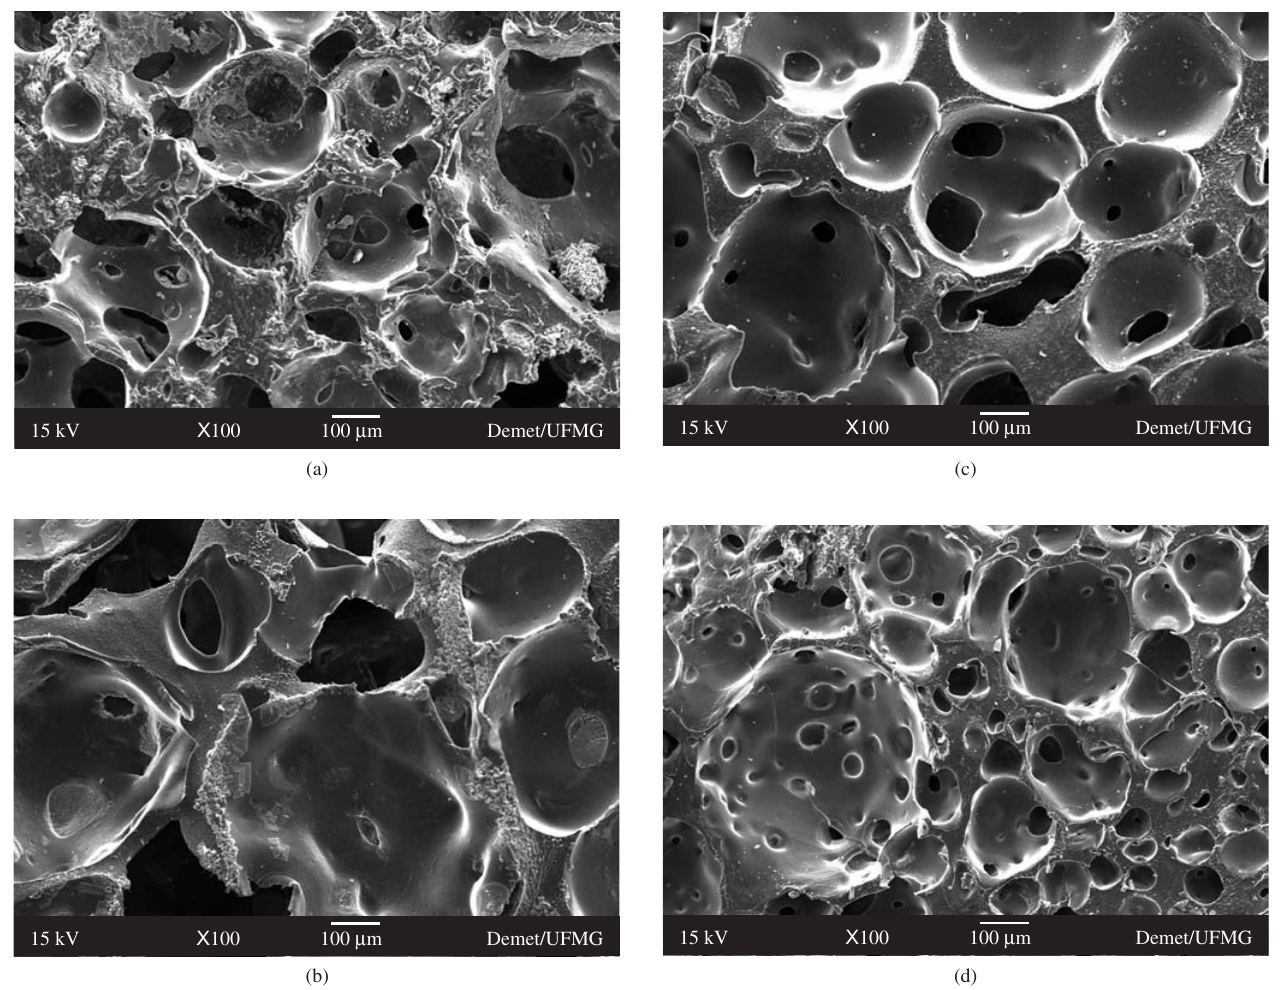
Figure 4. Scanning electron micrographs of hybrids: a) 70 wt. (%) PVA-30 wt. (%) Bioglass (3B-7Pc); b) 80 wt. (%) PVA-20 wt. (%) Bioglass (2B-8Pc); c) 70 wt. (%) PVA-30 wt. (%) Bioglass (3B-7Ph-35); d) 60 wt. (%) PVA-40 wt. %) Bioglass